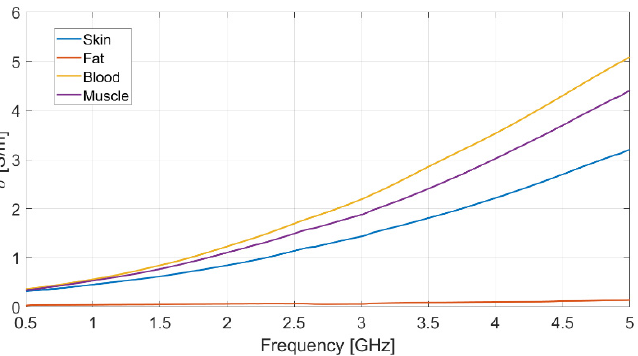
Figure 3. Measured imaginary part of the relative permittivity vs. frequency for each realized bio-phantom.